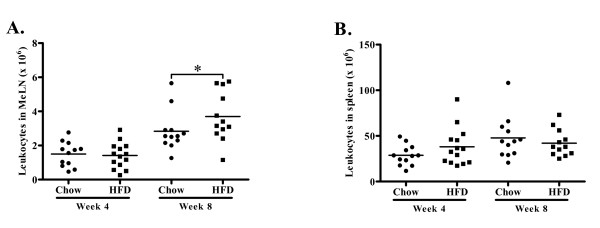
Total leukocyte counts. (A) There was no difference in MeLN total leukocyte number in mice receiving a high fat diet (HFD) compared to mice fed a chow diet at 4 weeks of diet but increased leukocyte number at 8 weeks of HFD compared to chow diet. (B) There was no difference in spleen total leukocyte number between mice receiving HFD compared to mice fed chow diet at 4 and 8 weeks of diet. *P < 0.05.